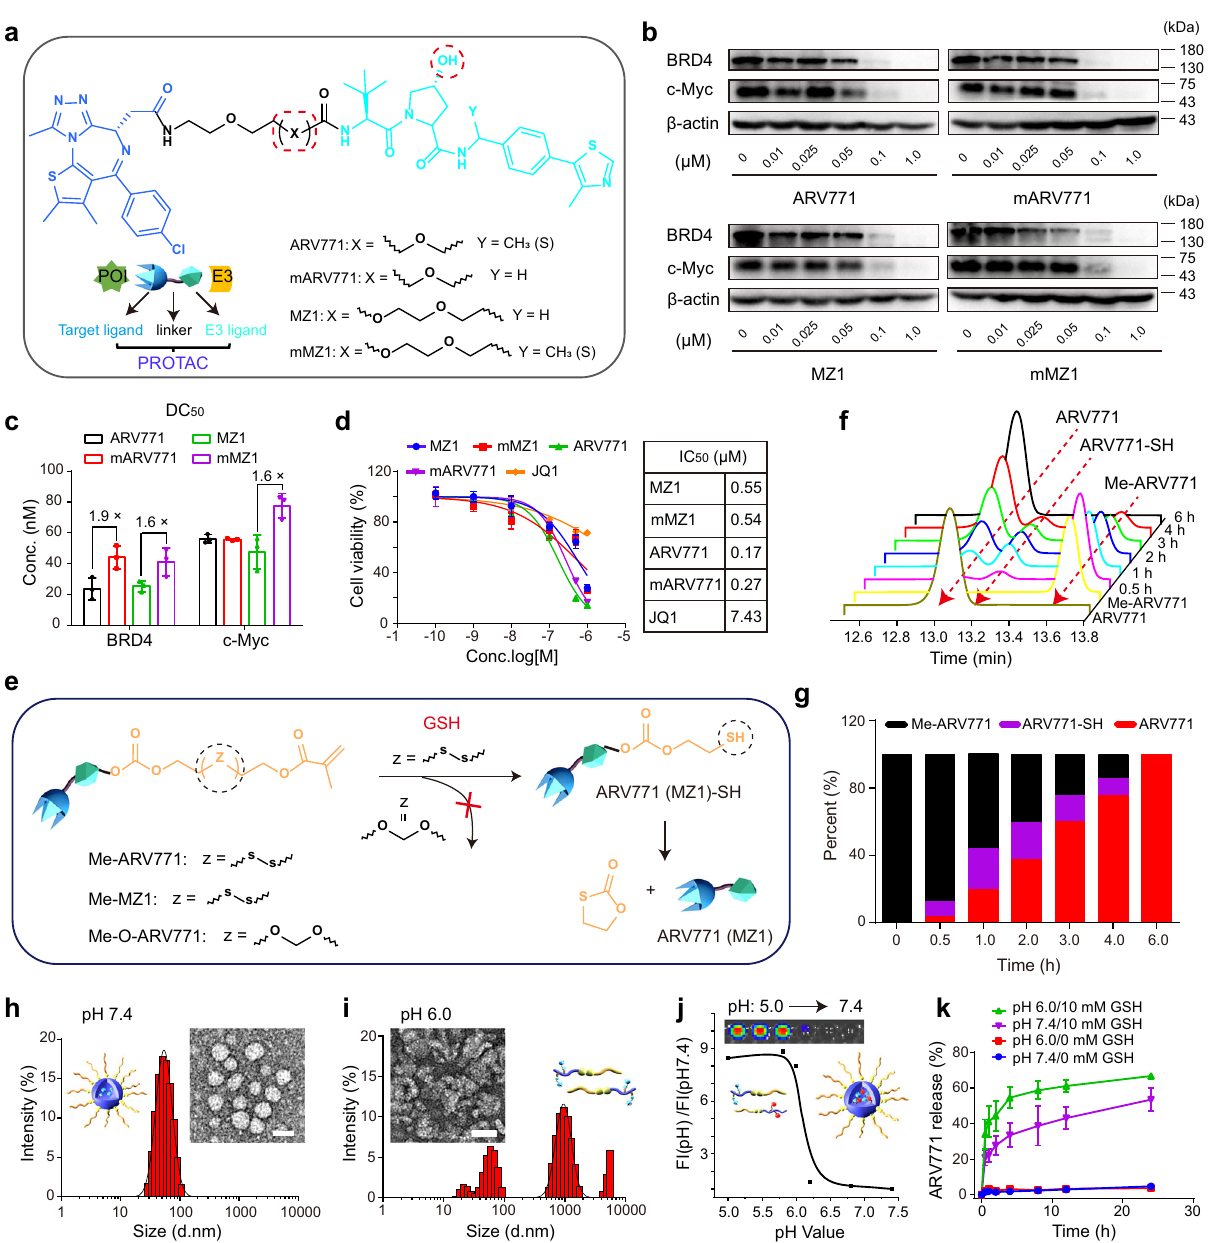
Fig.2|SynthesisandcharacterisationoftheBRD4PROTACandPOLY-PROTAC NPs. a Synthesis of the BRD4-targeted VHL PROTACs. b Western blot assay of PROTAC-mediated BRD4 degradation and c-Myc downregulation in MDA-MB- 231 breast tumour cells after 24h of incubation. c Western blot assay- determinedhalfBRD4degradationconcentration(DC 50 )valuesofthePROTACs ( n =3 biologically independent cells). d PROTACs ef fi ciently inhibited the pro- liferationofMDA-MB-231cellsinadose-dependentmannerinvitro(insetshows theIC 50 valuesoftheindicatedPROTACsandJQ1).Cellswereincubatedwiththe PROTACs or JQ1 for 72h before being subjected to the CCK-8 assay ( n =4 bio- logically independent cells). e Schematic illustration of the GSH-triggered